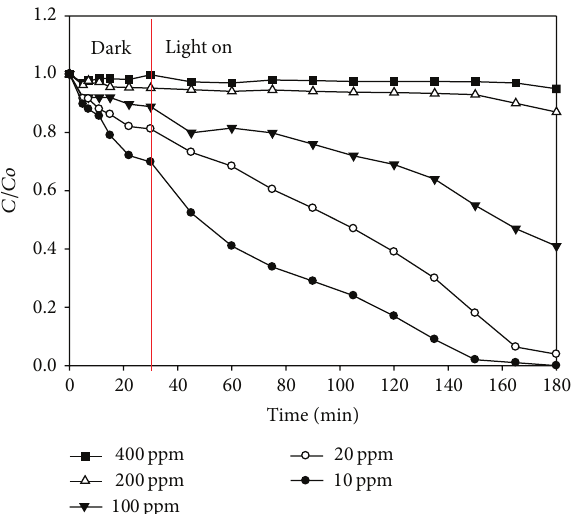
Figure 5: The curve of N 2 adsorption/desorption.